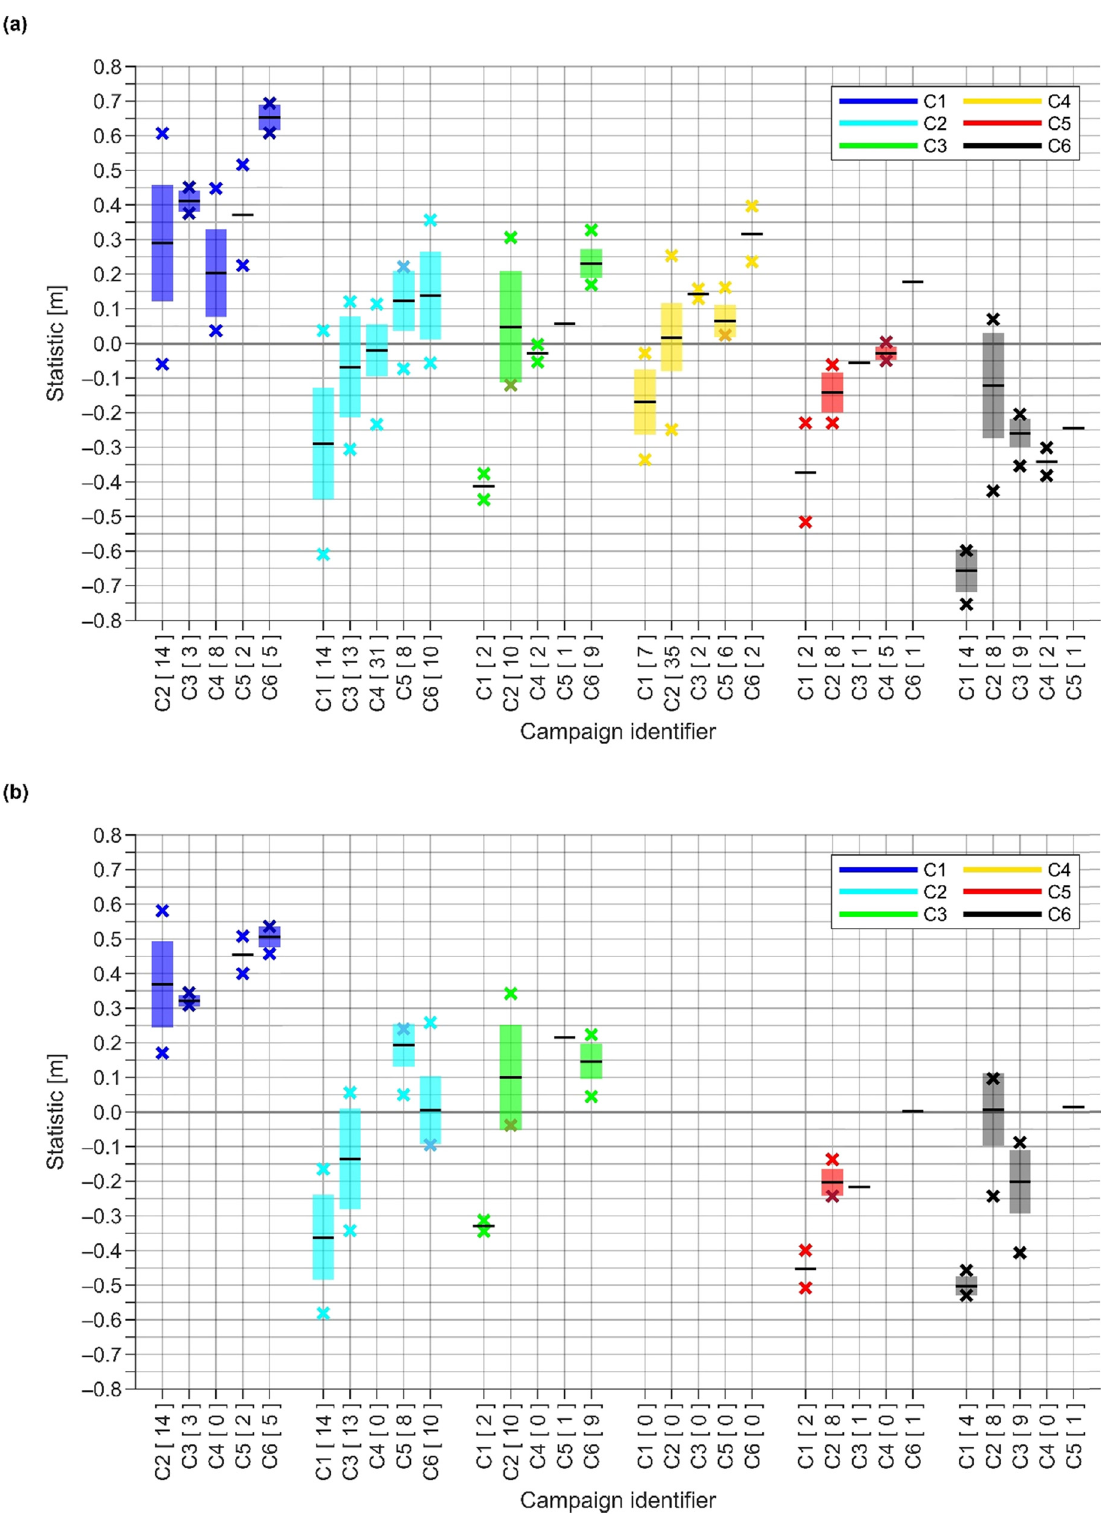
Figure 12: Statistical properties of di ff erences between low - pass fi ltered SSH of antennas A2 ( a ) and A4 ( b ) at intersections between campaigns. The black lines are mean di ff erences, and colored bars denote standard deviation estimates of di ff erences. Crosses denote minimum and maximum di ff erences. Note that color shows the validated campaign and the X - axis validation dataset. In square brackets are the total number of detected intersections for each